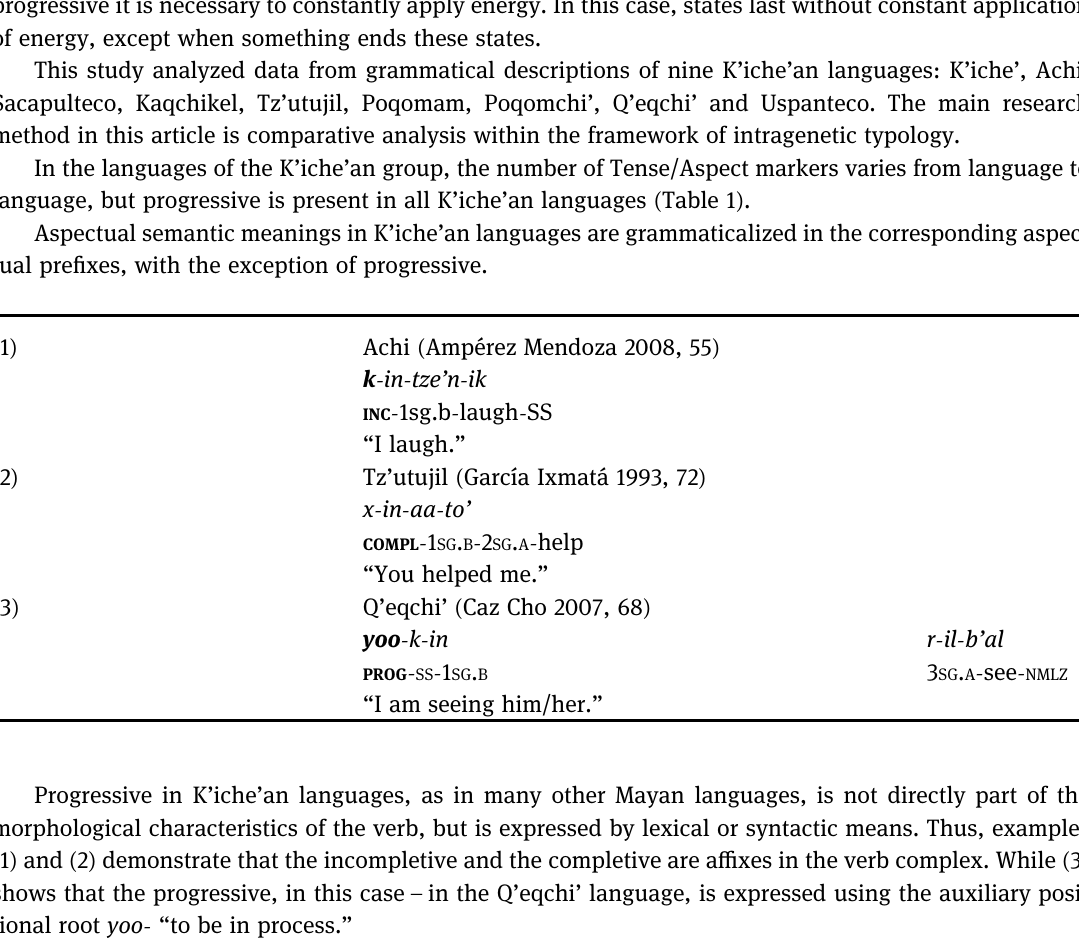
Table 1: Tense/Aspect category in K ’ iche ’ an languages ( the “ + ” sign means presence, “—” means absence )